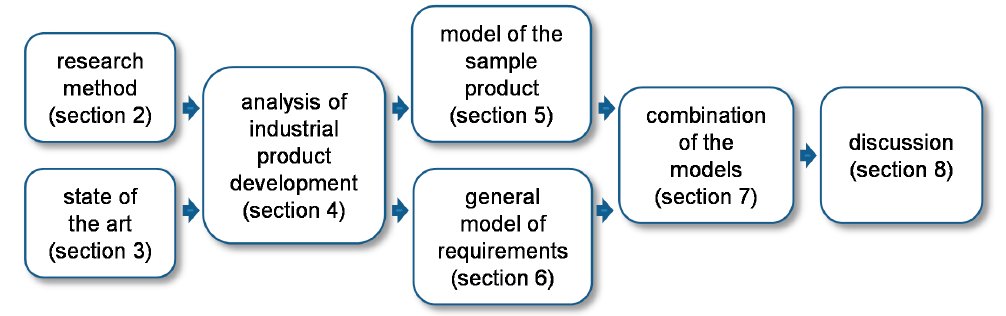
Figure 2. Structure of the paper.